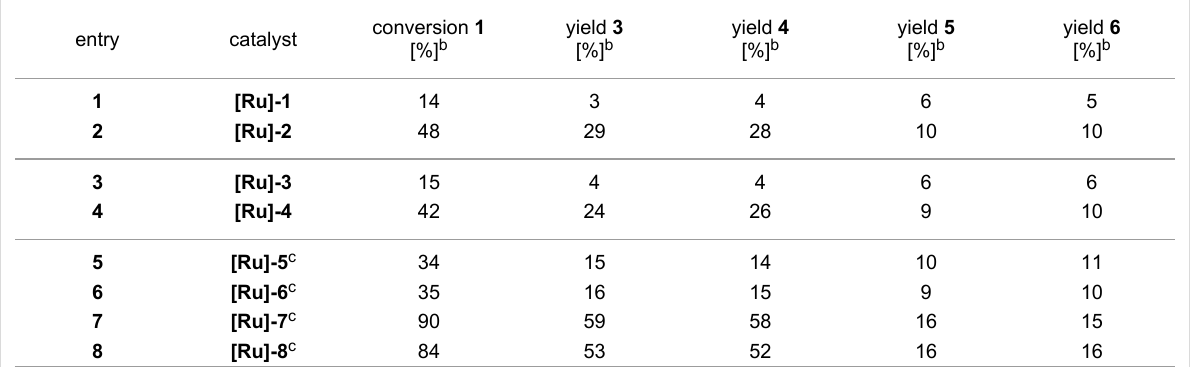
Table 1: Results of metathesis catalyst activities in the cross-metathesis of methyl oleate ( 1 ) with 2 .